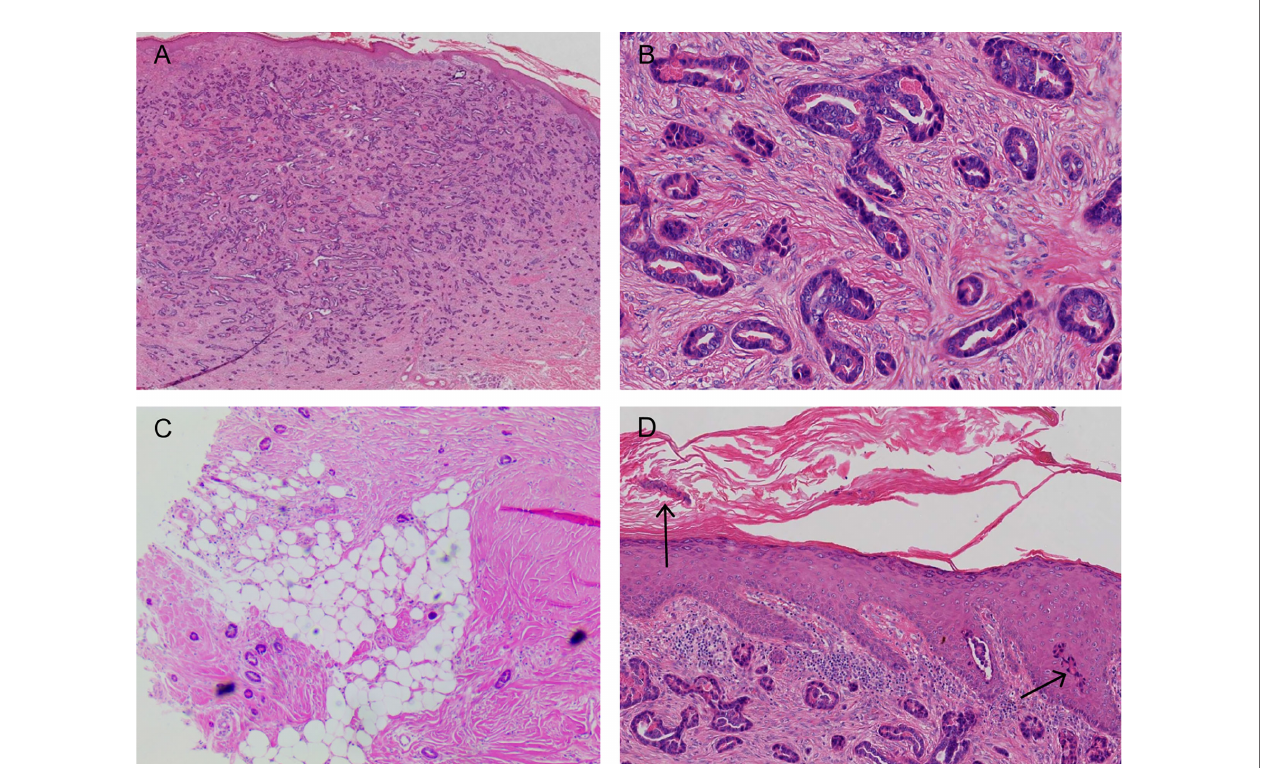
FIGURE 3 | (A, B) A large number of densely distributed ductal and cystic lumen-like structures in the whole dermis and mucus-like substances were visible in some lumina. The tumor cells were small, with round nuclei and occasionally karyokinetic images. (C) The tumor tissue in fi ltrated the fat layer (black arrow). (D) A few tumor cells nested in the epidermis (black arrow; hematoxylin and eosin: A , ×40; B , ×200; C , ×40; D ,